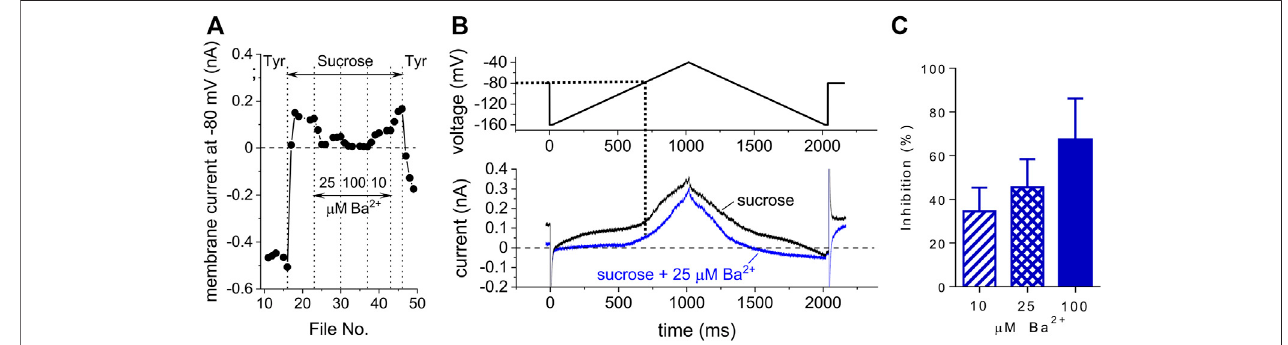
FIGURE7| EffectofBa 2+ onthemembranecurrentinthepresenceofsucrose. (A) Timecourseofchangesofthemembranecurrentat − 80 mVinarepresentative cell during consecutive application of sucrose alone and in combination with 10, 25, and 100 μ M Ba 2+ . (B) Changes ofthe membrane current during a ramp stimulation (lower panel; for thestimulation protocol, see the upper panel). (C) Average inhibitionofthe membrane current at − 80 mV insucrose at 10,25, and 100 μ M Ba 2+ ( n =3).